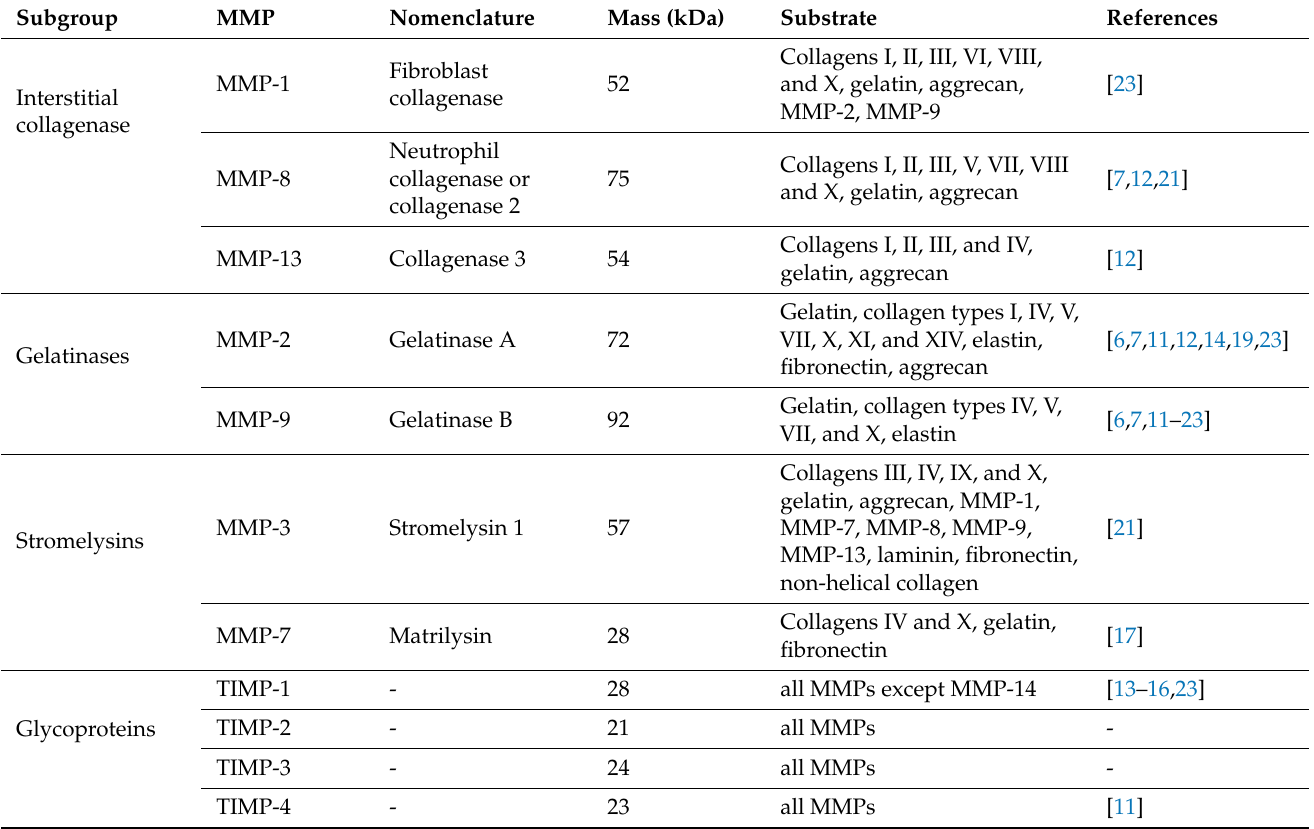
Table 2. Matrix metalloproteinases and tissue inhibitors of matrix metalloproteinases identified in human myocardium during and after cardiac surgery with cardiopulmonary bypass.